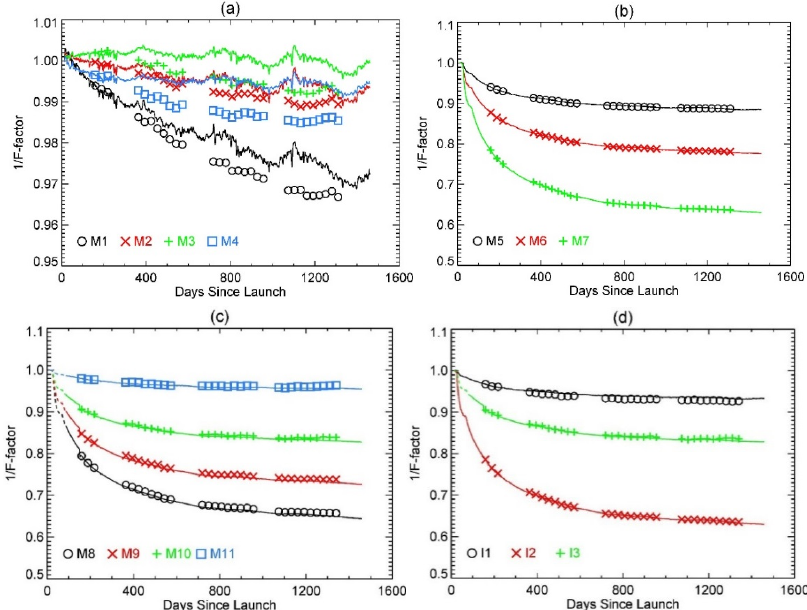
Figure 3. 1/F-factors (gains) trends for the RSB: ( a ) for bands M1–M4; ( b ) for bands M5–M7; ( c ) for bands M8–M11; and ( d ) for bands I1–I3. The solid lines represent the SD observations, and the symbols denote the lunar observations. The lunar 1/F-factors are scaled so that their values on 2 April 2012 (157 days after launch) exactly match their corresponding SD 1/F-factors.